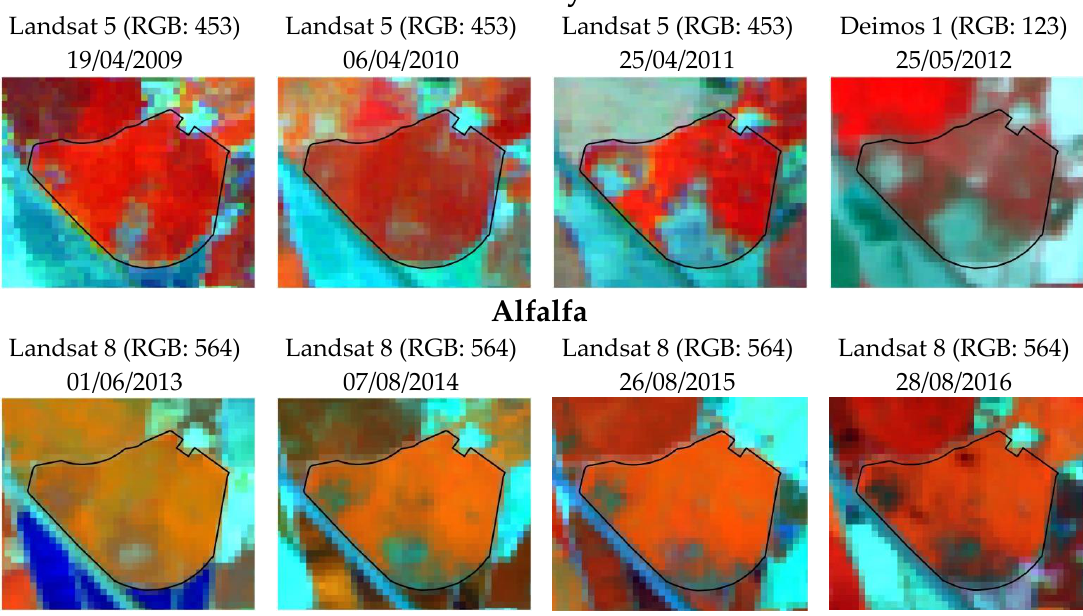
Figure 6. False color compositions from satellite images of the studied field.